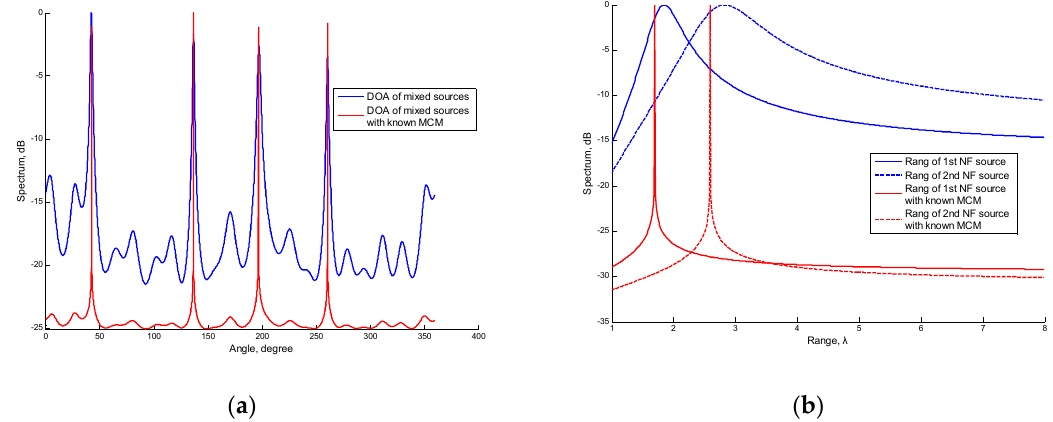
Figure 2. ( a ) Azimuth spectrum of two stage multiple signal classification (TSMUSIC)-like at ϕ= 65°; ( b ) Range spectrum of TSMUSIC-like.